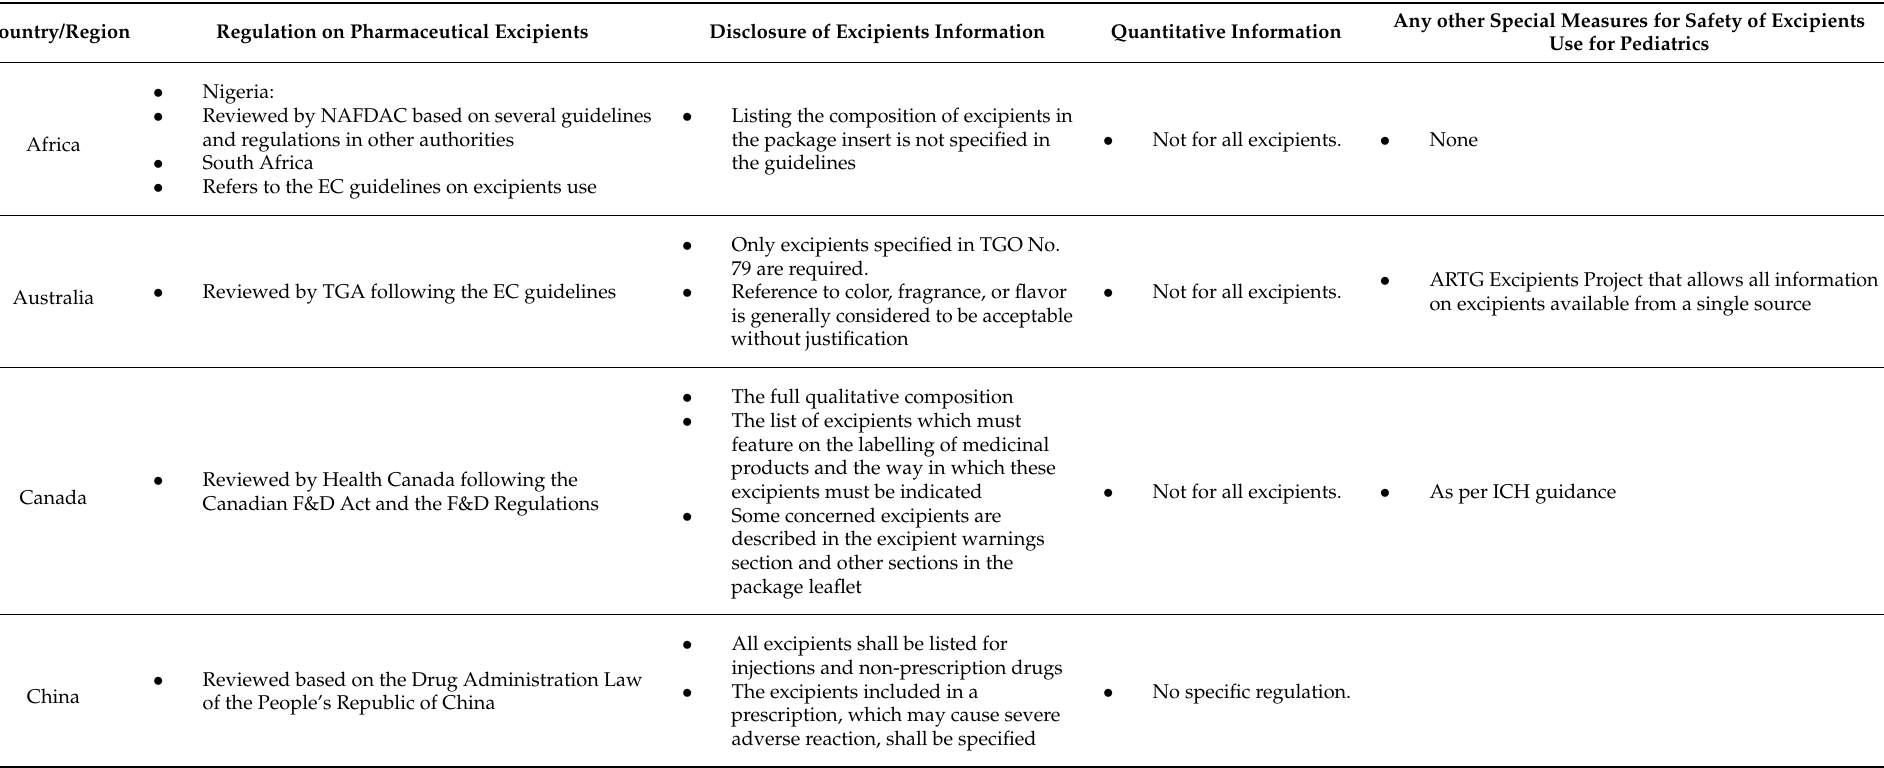
Table 1. Excipient regulation, disclosure statements of excipient in pharmaceutical products, and other measures for safe excipient use in each country and